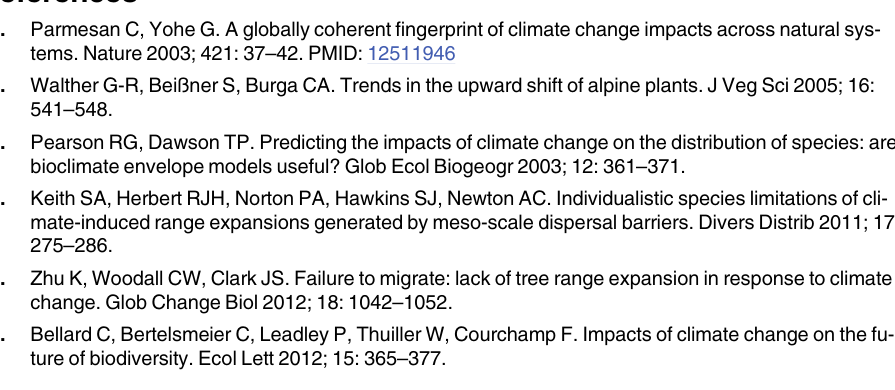
S2 Table. Mean (±se) biomass of saltmarsh plants (g dry weight x m -2 ) by distance (m) from mangrove tree line at two locations (north and south) on Cannon Island in November